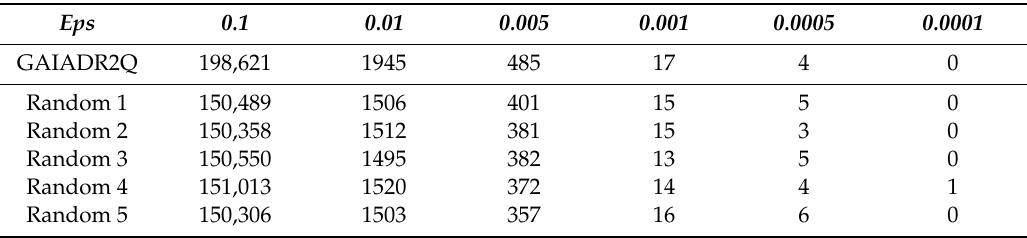
Table 19. Number of opposite pairs for selected angular accuracy values eps in GAIA DR2 quasar catalog and five random catalogs with the same number of objects, evenly randomly distributed on the celestial sphere.